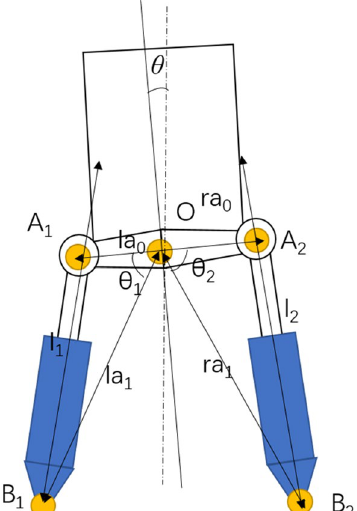
Figure 3. The swing schematic.